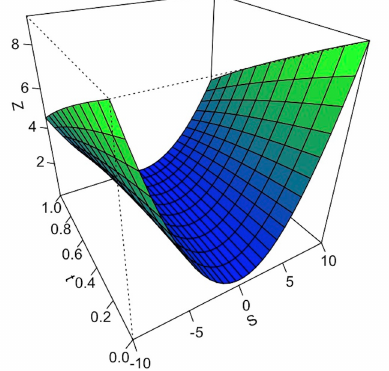
Figure 1. The value